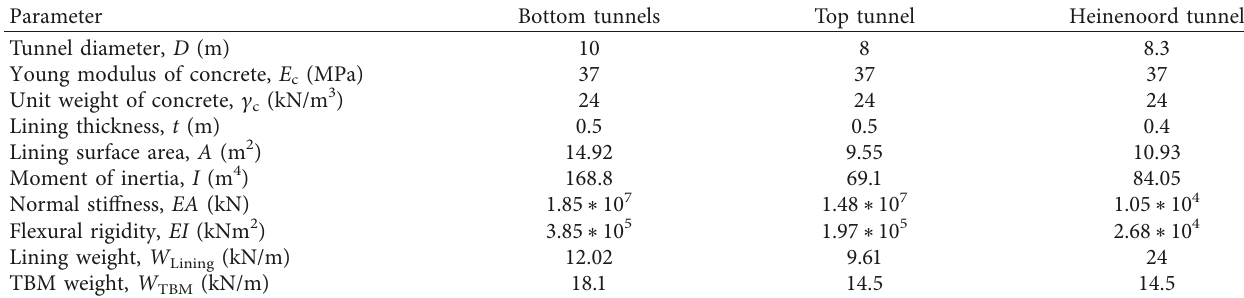
Table 4: Overview of the tunnel lining parameters (Schotte et al. [24]).